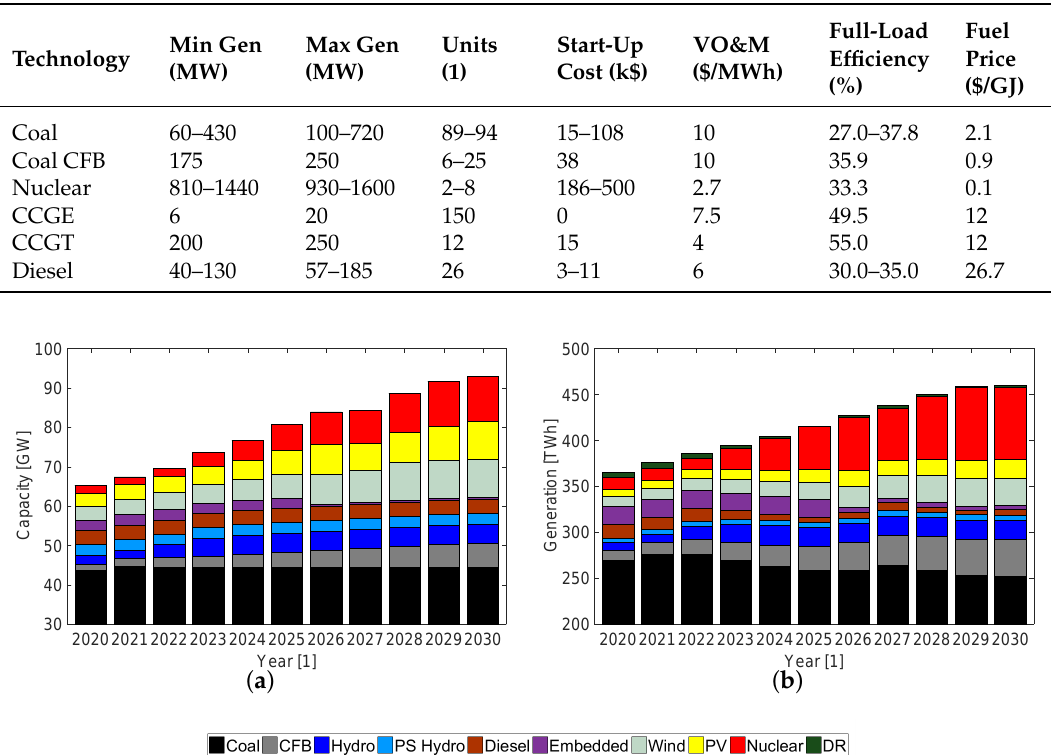
Table 1. Technical parameters and their intervals for thermal power plant mix. The intervals are used as the power plant fleet contains plants with different technical characteristics. In the case of the unit numbers, the interval indicates the commitment of new plants during the studied timespan.